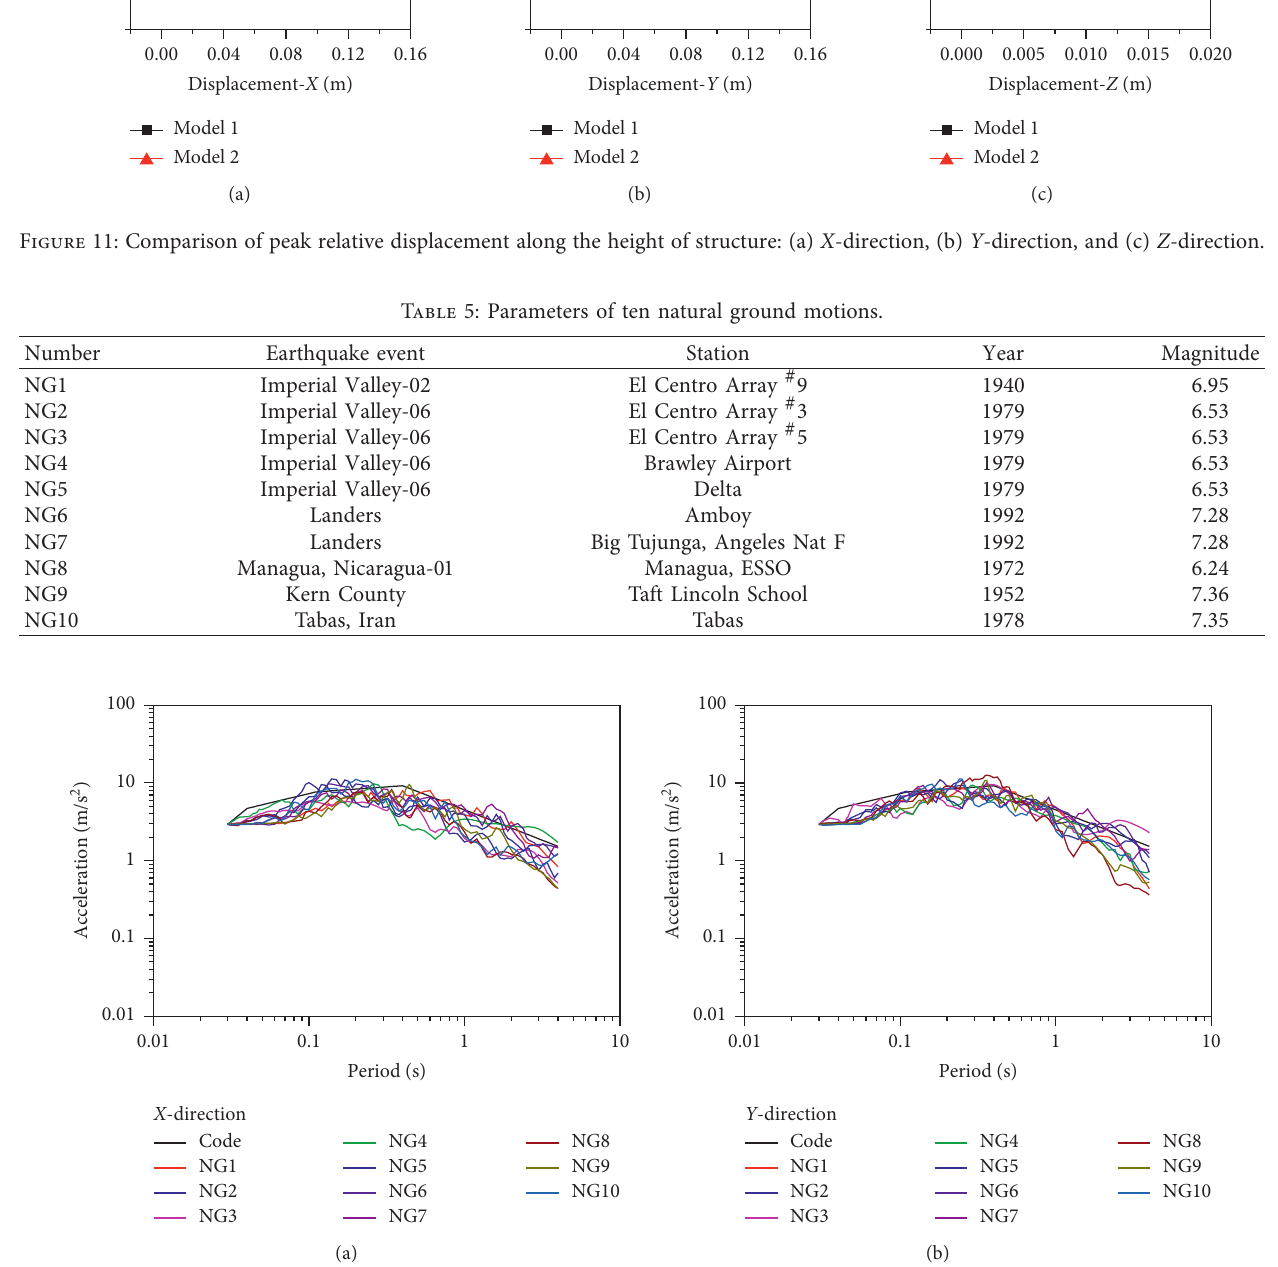
Figure 12: Acceleration response spectra with the damping ratio of 0.5%: (a) X -direction and (b) Y